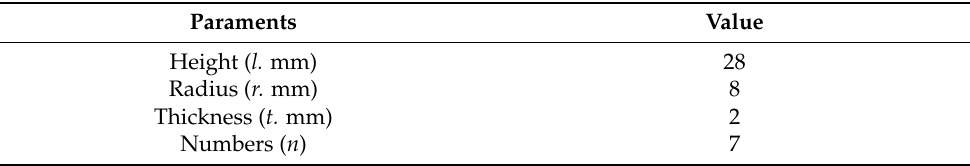
Figure 3. The influence of different structural parameters on bellows deformation. ( a ) The effect of the rectangular chamber’s numbers on the elongation; ( b ) The effect of the rectangular chamber’s numbers on the expansion; ( c ) The effect of the thickness of the bellows on the elongation; ( d ) the effect of the bellows thickness on the expansion. Table 1. The bellows actuator’s structure